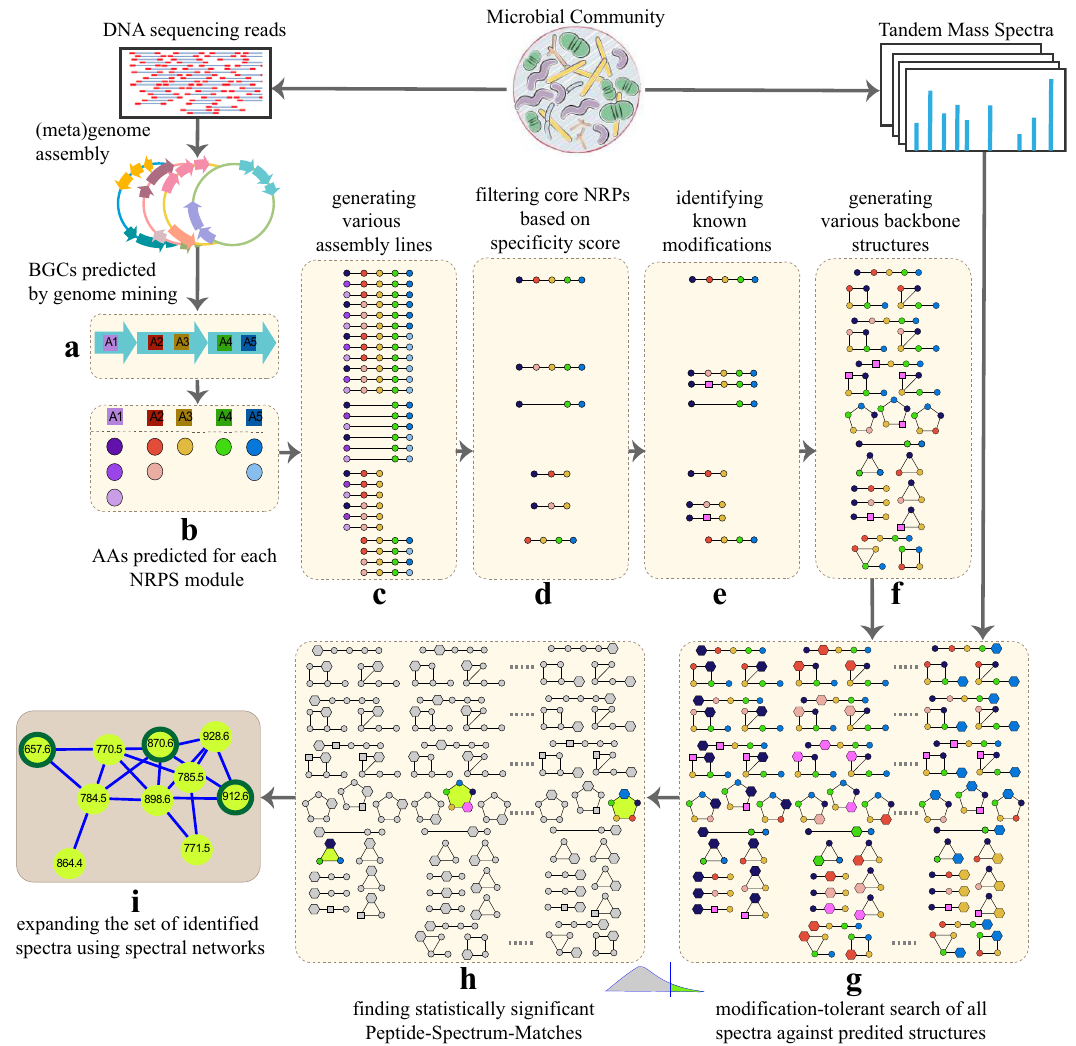
Fig. 1 NRPminer pipeline. a Predicting NRPS BGCs using antiSMASH 16 . Each ORF is represented by an arrow, and each A-domain is represented by a square, b predicting putative amino acids for each NRP residue using NRPSpredictor2 (ref. 15 ), colored circles represents different amino acids (AAs),